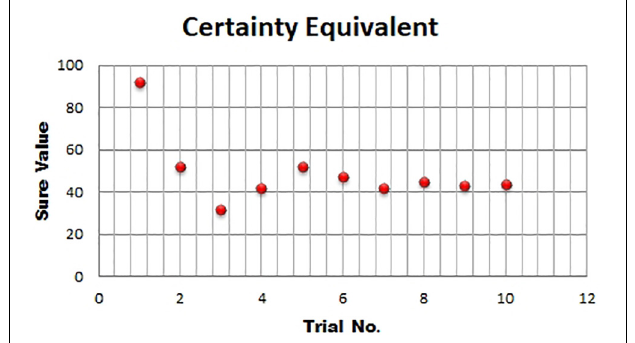
FIGURE 1 | Certainty Equivalent of a gamble that yields a gain of Rs. 90 with 50% probability or Rs. 10 with 50% probability. It starts with a choice between a gamble and a sure value. Selection of sure value leads to a decrease in the value of the sure option by half of the range of gamble. The procedure continues until the step size becomes less than or equal to 2.